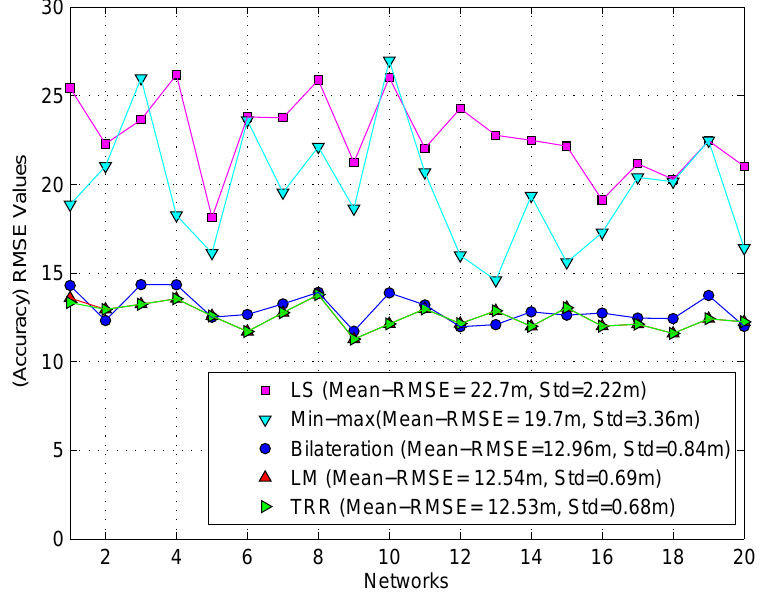
Figure 5. Position estimates provided by different initialization